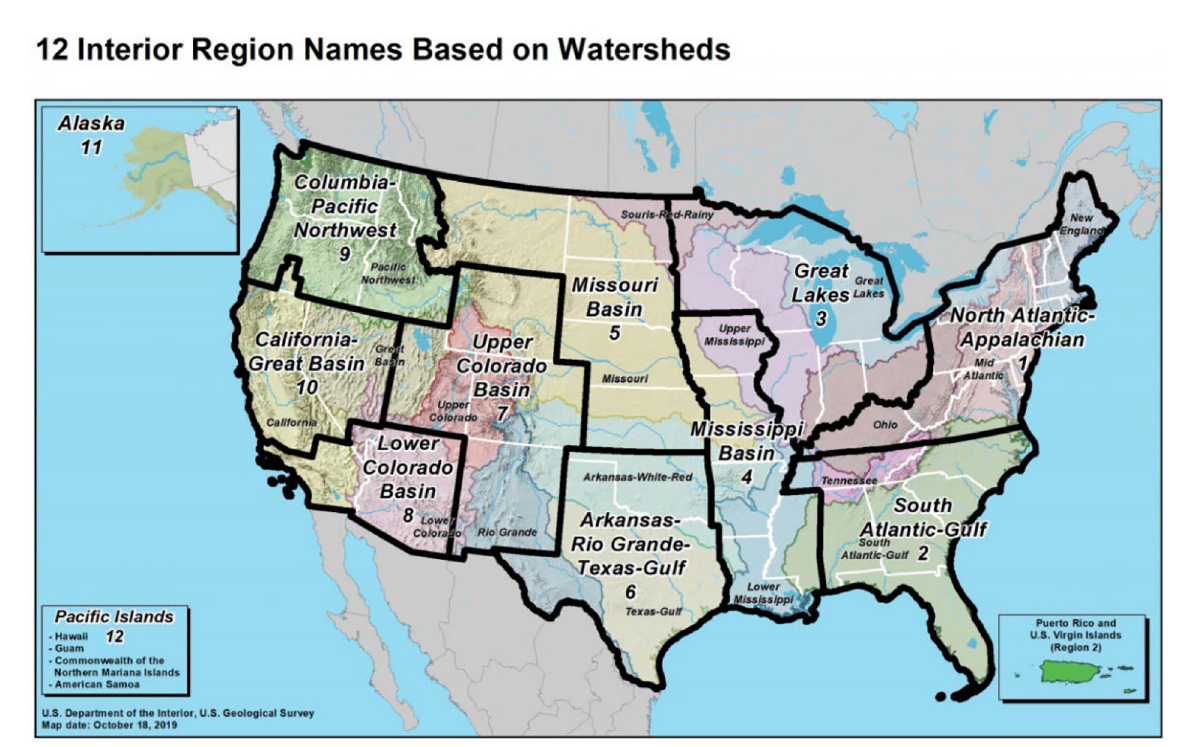
FIGURE4 U.S. Department of the Interior (2019). Map of U.S. Department of interior regions based on